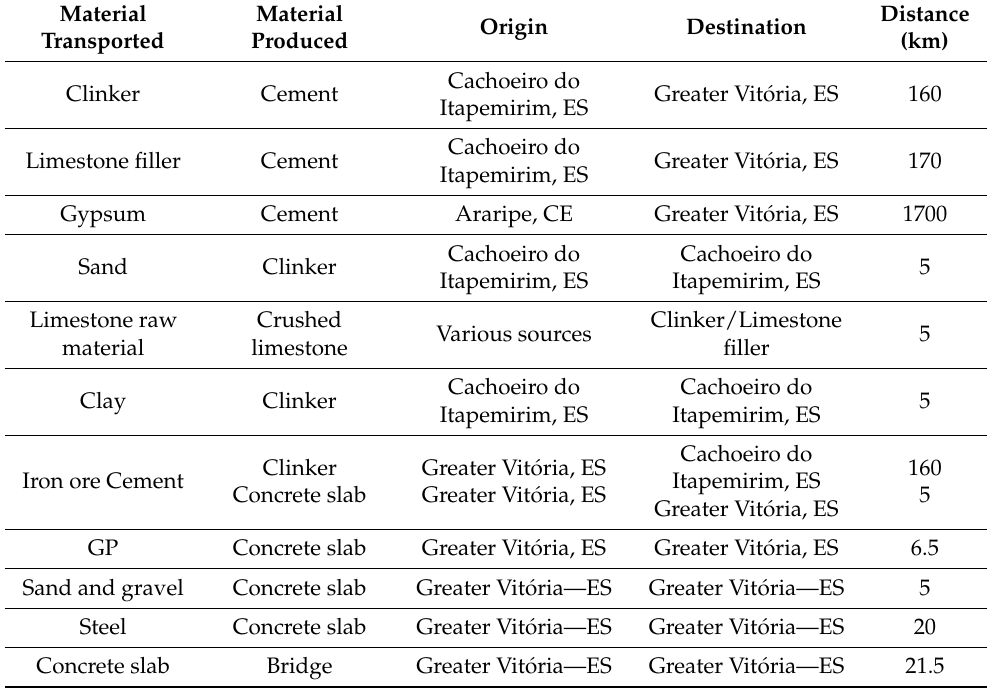
Table 8. Transportation distances of the